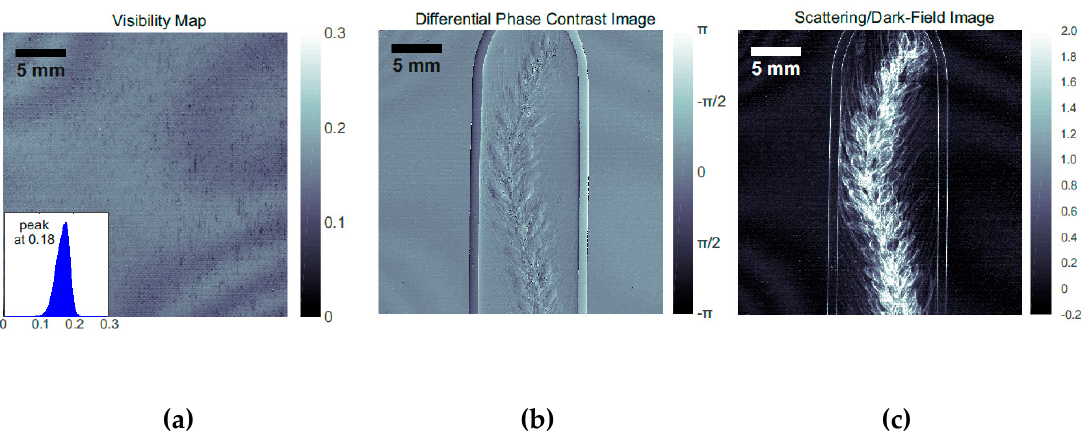
Figure 13. X-ray performance of an Au electroplated grating of 6 µm period used as a G 0 absorbing grating. X-ray fringe visibility map and visibility histogram as insert ( a ), differential phase contrast ( b ), and scattering ( c ) images of a grain ear. The figure was adapted with permission from L. Romano et al, 2020. [21].